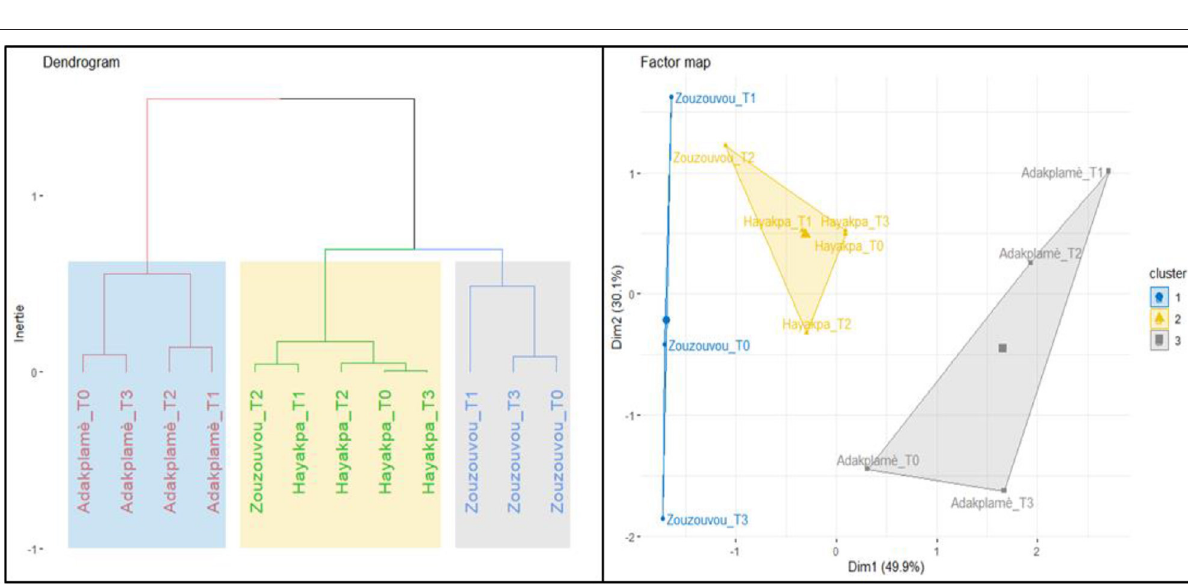
FIGURE 10 | Dendrogram of classes obtained and projection of treatments in the first two dimensions of PCA. T 0 :100% NPK + Urea; T 1 : clay + P. putida + ½ NPK + Urea, T 2 : peat + P. putida + ½ NPK + Urea, T 3 : clay-peat + P. putida + ½ NPK +